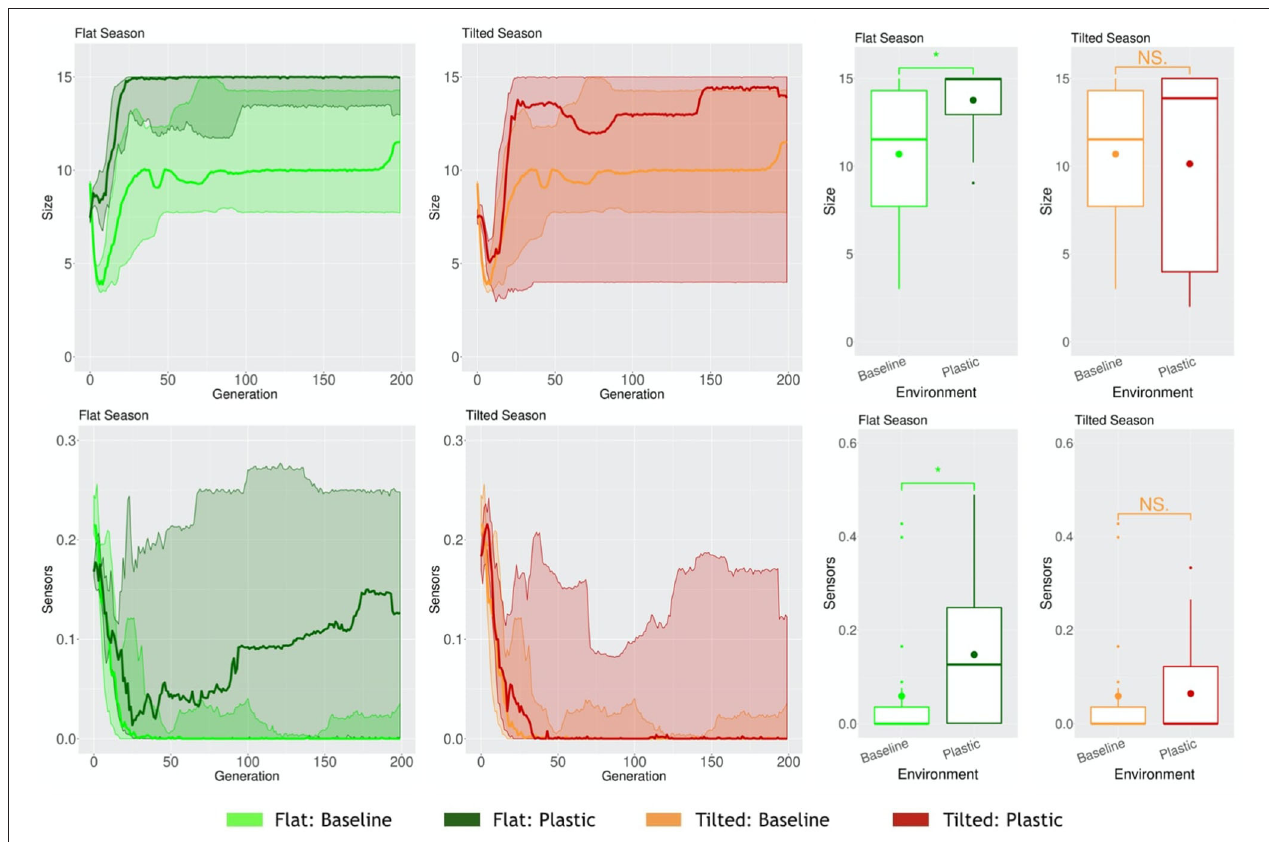
FIGURE 11 | Comparison of morphological properties in different environmental conditions. Line plots show the progression of the means of the population (quartiles over all runs), while boxplots show the distribution of the means in the final generation. Significance levels for the Wilcoxon tests in the boxplots are ∗ < 0.05, NS not significant. Note that, naturally, the values of Baseline are the same in Flat or